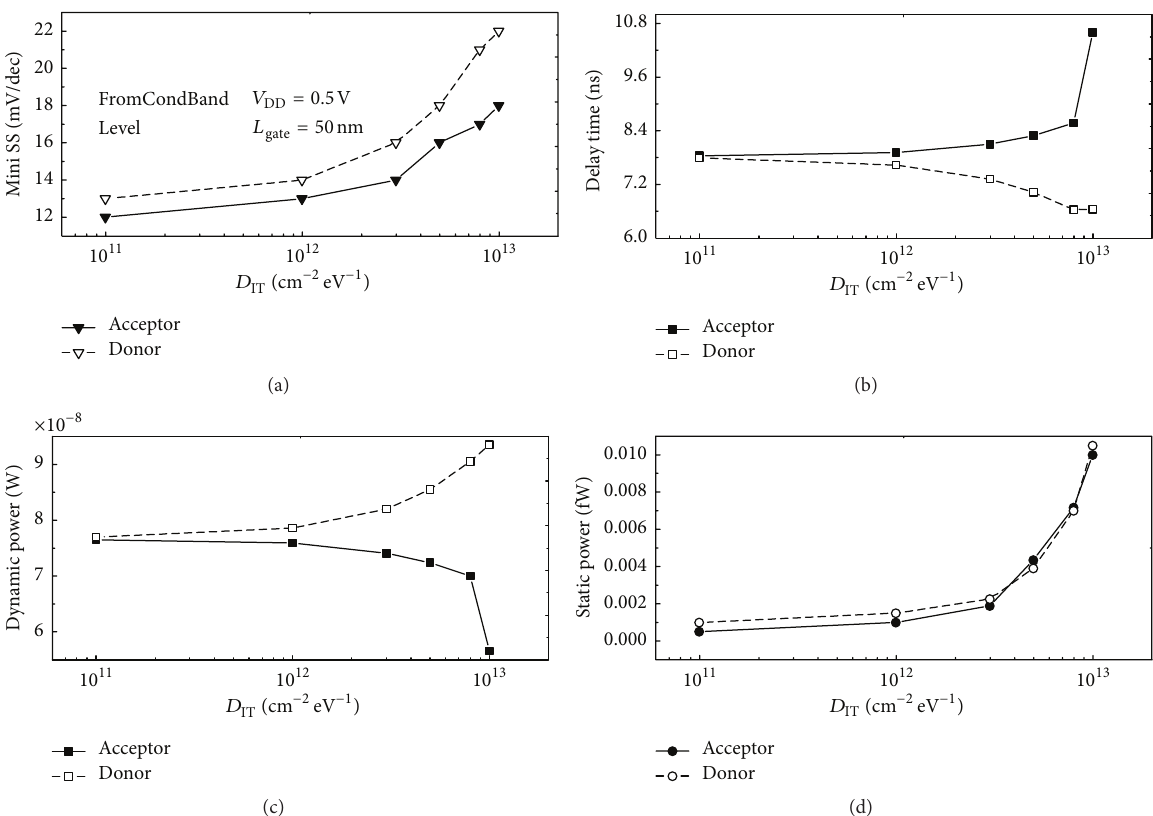
Figure 12: (a) The calculated mini SS, (b) delay time, (c) dynamic power, and (d) static power versus ITs density at valence band. Delay time 𝑉 /𝐼 𝜏 is given by 𝐶 . The acceptor-type ITs can reduce the dynamic power and the mini SS is more immune to acceptor-type ITs. 𝐿 DD on